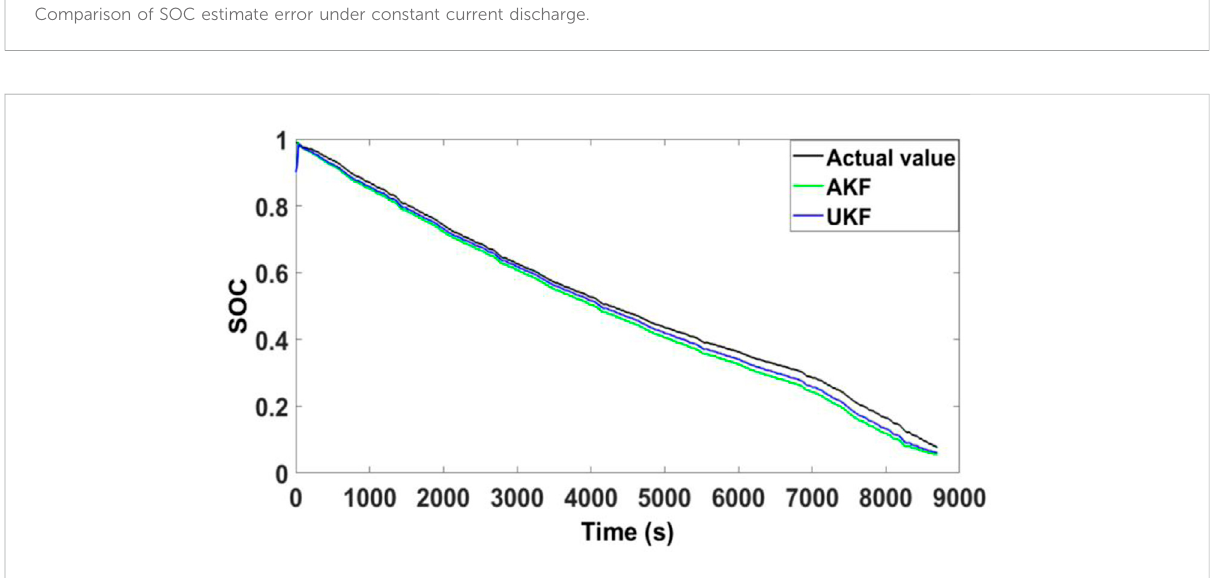
FIGURE 8 SOC estimate results under UDDS